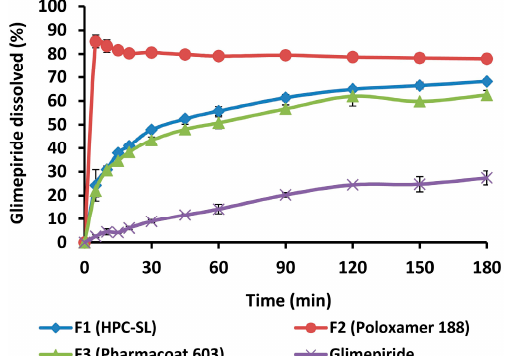
Figure 10. Dissolution profiles of glimepiride from the samples of pure drug and spray dried